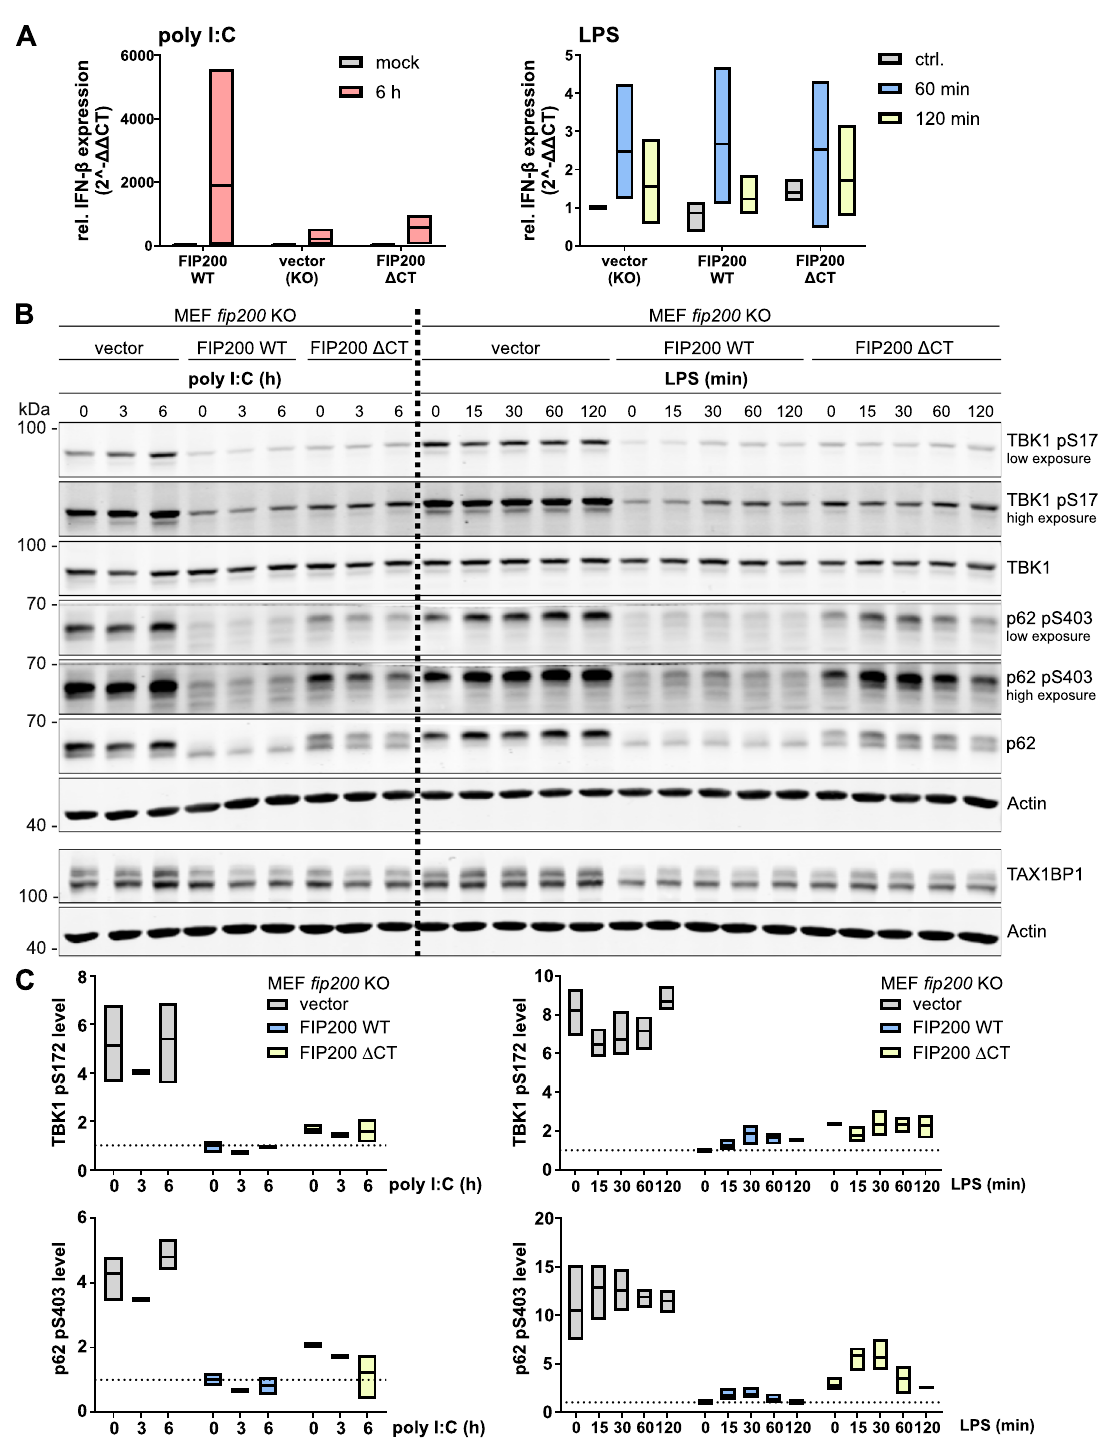
Figure 7. FIP200 deficiency desensitizes cells to TLR3-/TLR4-engaging stimuli. ( A–C ) fip200 KO, FIP200 WT, and FIP200 ΔCT MEFs were transfected with 2 µg/ml poly I:C or treated with 1 µg/ml LPS for the indicated times. dH 2 O was used for mock transfection. ( A ) RT-qPCR analyses were performed to determine the relative IFN-β expression. All values were normalized to those of control samples of FIP200 WT MEFs. The boxes represent the highest and the lowest value, while the centerline shows the mean from three independent experiments. ( B ) Lysates of poly I:C-transfected or LPS-treated cells were immunoblotted for the indicated proteins. Representative immunoblots of three independent experiments are depicted. The full-length blots are presented in Figure S10. ( C ) The densities of the bands on immunoblots from three independent experiments (except for 3 h poly I:C transfection, which was performed only once) were quantified and normalized to those of Actin. The normalized densities of all samples were then normalized to that of the respective untreated sample of FIP200 WT cells. Only the relative levels of TBK1 pS172 and SQSTM1/p62 pS403 are shown. The boxes represent the highest and the lowest value, while the centerline shows the